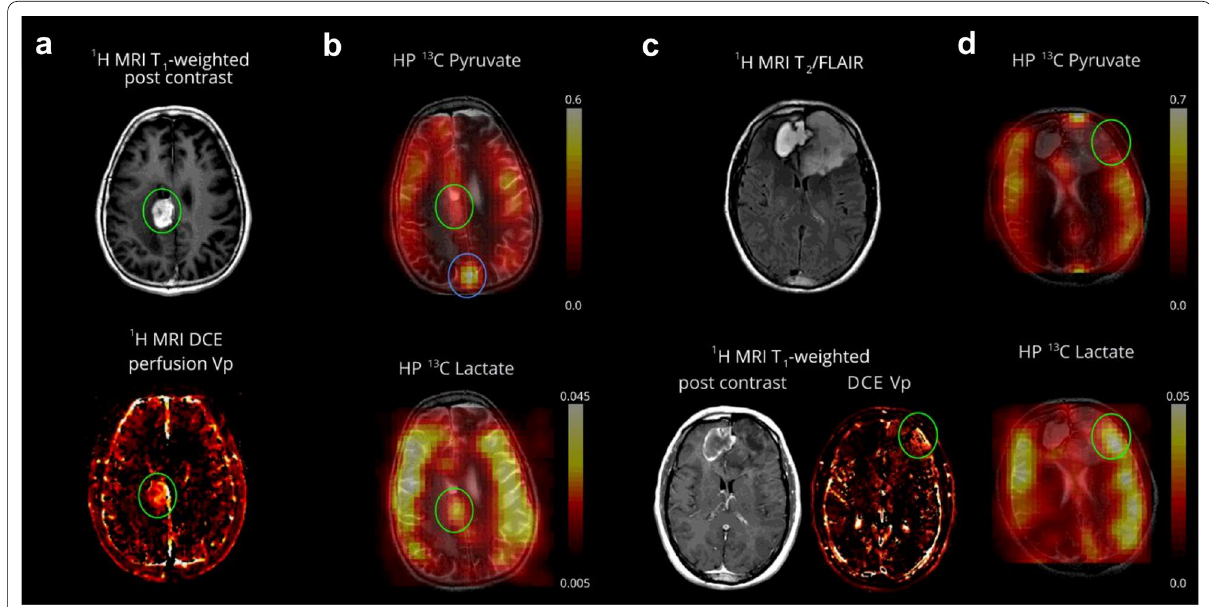
Fig. 4 Pyruvate metabolism in a recurrent glioblastoma and treatment-related changes (Patient 2, a and b) and anaplastic oligodendroglioma (Patient 1, c and d). An enhancing mass is located in the right cingulate gyrus (green oval) ( a ). The hyperpolarized pyruvate map shows high signal corresponding to the cortex/juxtacortical regions and superior sagittal sinus. The volume normalized pyruvate signal in the lesion is 1.3-fold higher than the entire brain. The HP lactate map shows mildly elevated signal corresponding to the lesion, similar to background lactate production by the brain. The volume normalized lactate signal in the lesion is 1.0-fold of the lactate over the entire brain (cortex and white matter) ( b ). The T2-FLAIR image shows an expansile left frontal mass and contracting right frontal hematoma. The left frontal mass has minimal, patchy enhancement and a small component of elevated plasma volume (green oval) visualized by DCE MRI ( c ). The HP pyruvate map shows high signal corresponding to the cortex/juxtacortical regions and superior sagittal sinus, but relatively lower signal corresponding to the small hyperperfused component. The HP lactate map shows mildly elevated signal corresponding to the hyperperfused component, similar to background lactate production by the brain ( d ). Cancer Res.